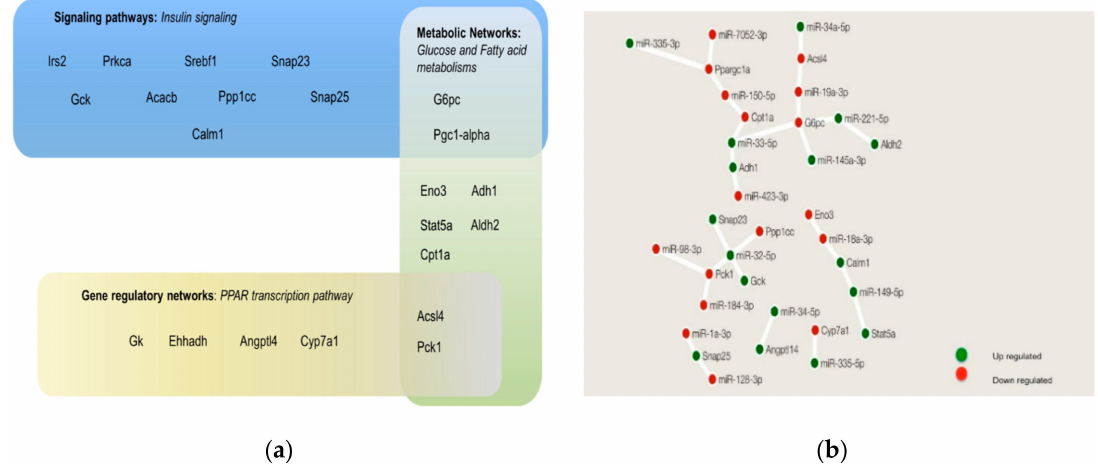
Figure 5. Interactions between miRNAs and genes in pathways related to insulin signaling, PPAR signaling, glucose and fatty acid metabolism. ( a ) Representation and compartmentalization of master genes involved in the selected pathways. ( b ) miRNAs-genes interactions of the genes represented in ( a ), obtained following the MMRA pipeline; green circles represented upregulated network components and red circles were downregulated network components. Construction of the network in ( b ) was done using Cytoscape